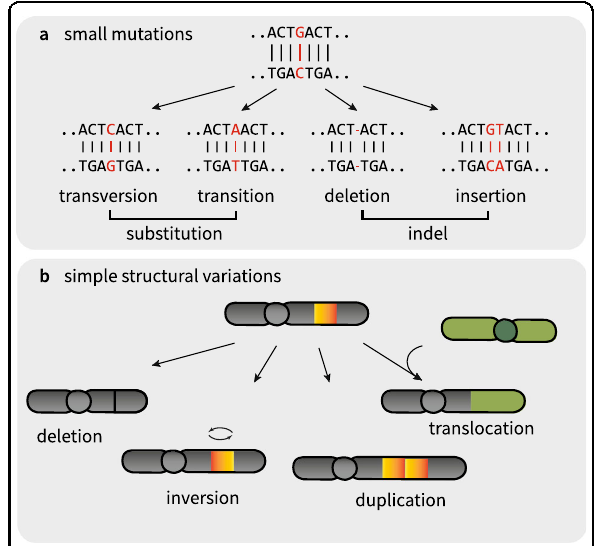
Fig. 2 Types of basic genomic variations. a Small mutations, base substitution and indels. b Simple structural variations, deletion, ampli fi cation, inversion, and interchromosomal